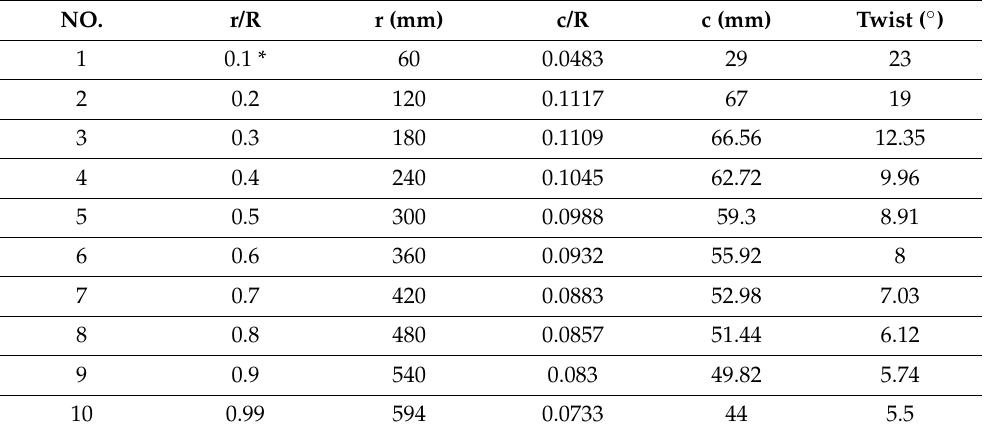
Figure 16. Three-dimensional model. Table 5. Comparison of airfoil structure before and after optimization.